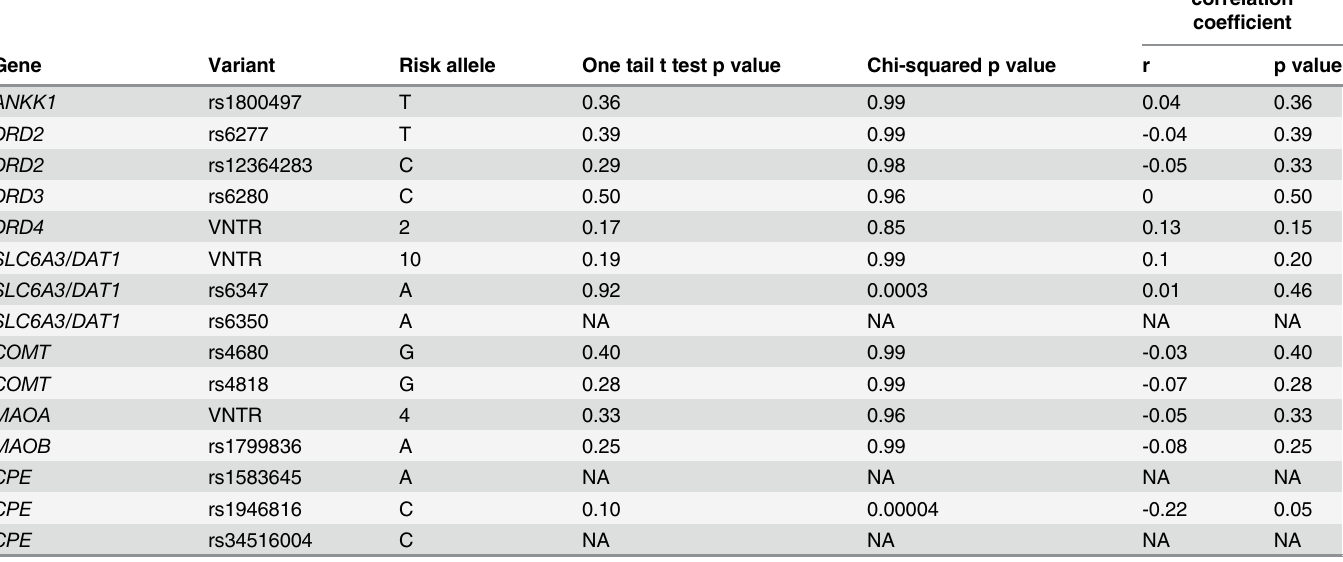
Table 3. Comparison of genotype by risk allele.